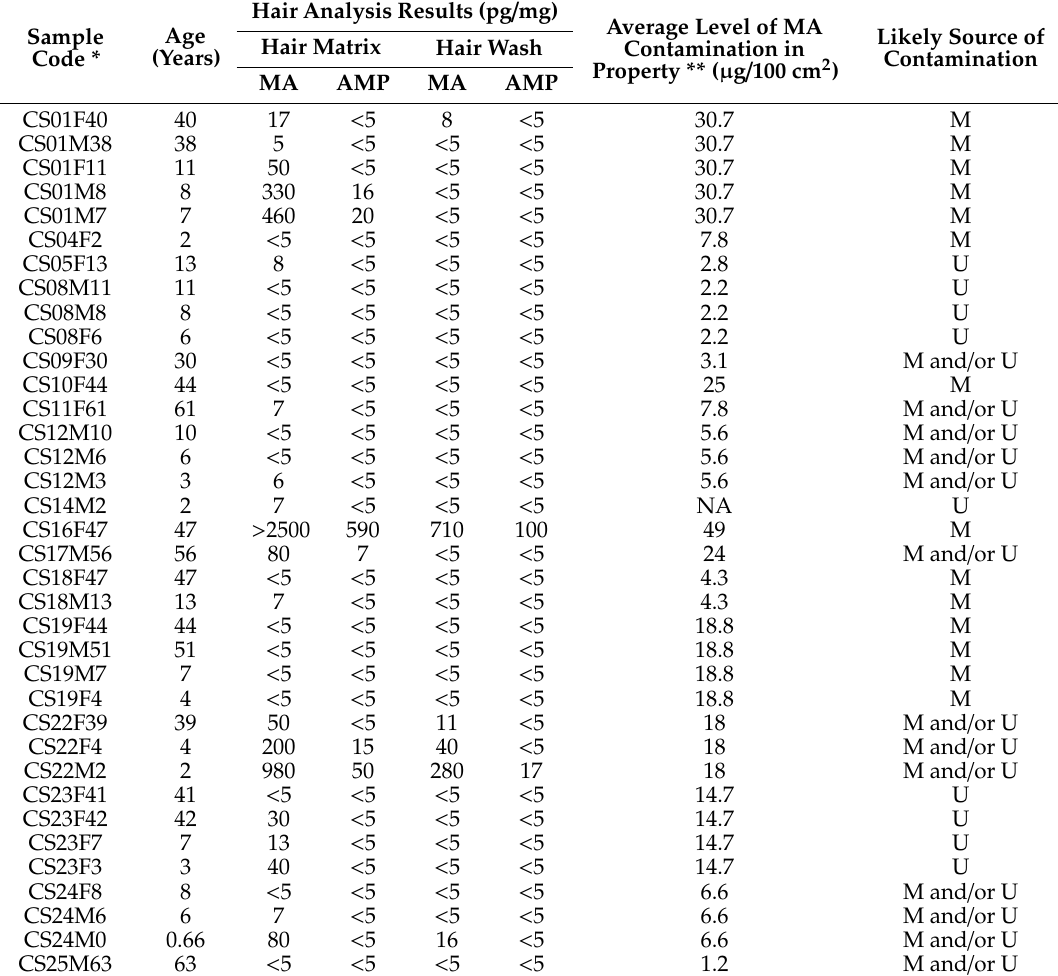
Table 4. Results of hair analysis for